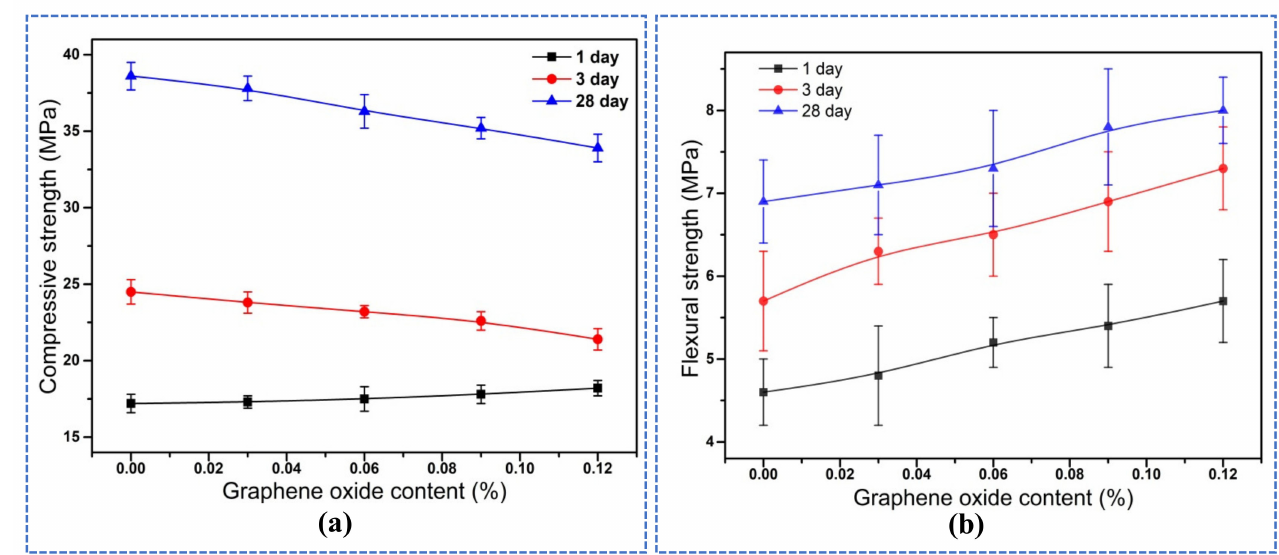
Figure 4. Mechanical Properties of mortars with GO ( a ) Compressive strength ( b ) Flexural